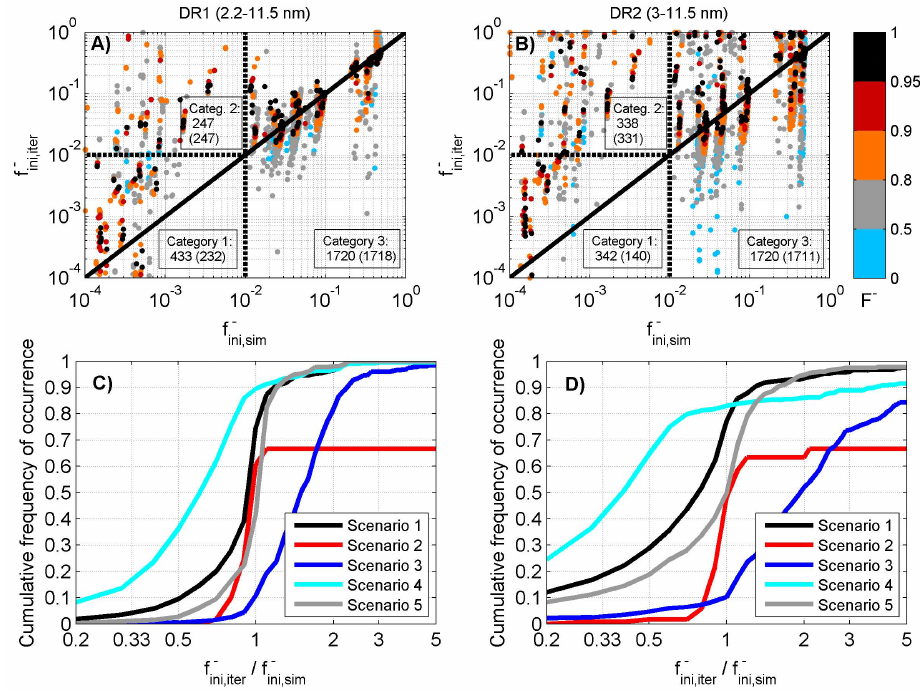
Fig. 7. The initial negative charged fractions determined with the iteration method using asymmetric small ion concentrations as a function of the initial charged fractions in the simulation are depicted in the upper panels for two diameter ranges. The colour denotes the fraction of the change rate of the negative charged fraction that was taken into account in the method (see details in Appendix B). The solid black line denotes the one to one correspondence and the dashed lines divide the data points into the 3 categories described in Sect. 4.4. The numbers denote the number of data points in each category with the numbers in parenthesis denoting the number of data points shown in the figure. < 1 × 10 − 4 . The cumulative frequency of occurrence of the ratio The points not shown in the figure had either the value of f − or f − ini,iter ini,sim of the fitted and the simulated initial charged fraction are depicted in lower panels with different colours denoting different growth scenarios used in the simulations. Only the data points in category 3 of (A) and (B) were used to obtain the curves in (C) and (D) , respectively. The panels on the left ( A and C ) and right hand side ( B and D ) denote the results obtained using data from DR 1 (2.2–11.5nm) and DR 2 (3–11.5nm),